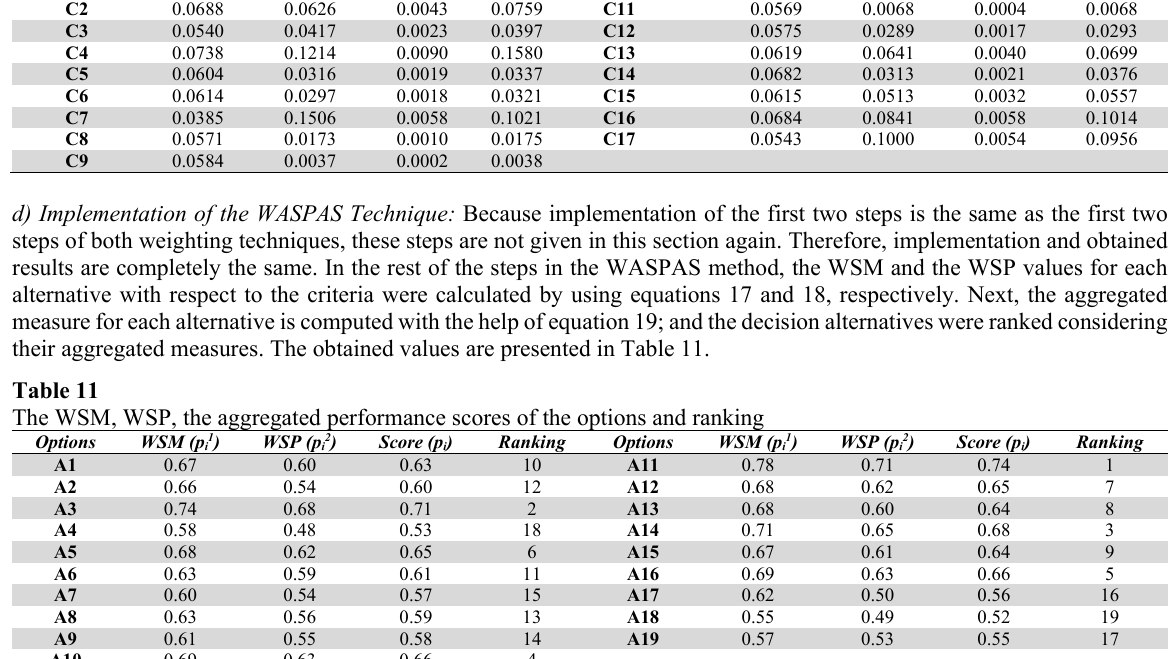
The final aggregated criteria weights